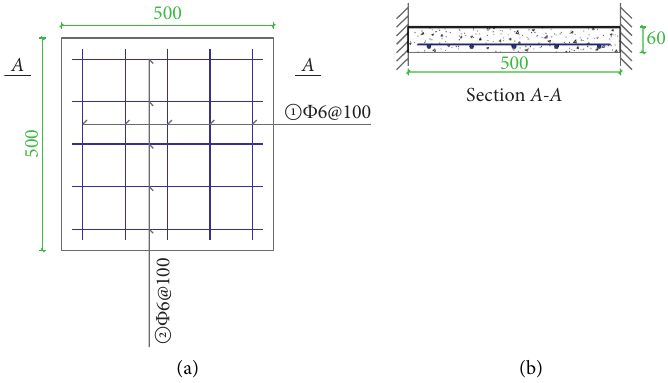
Figure 10: Geometry and reinforcement of the RC slab. Note: all dimensions are in millimeters.